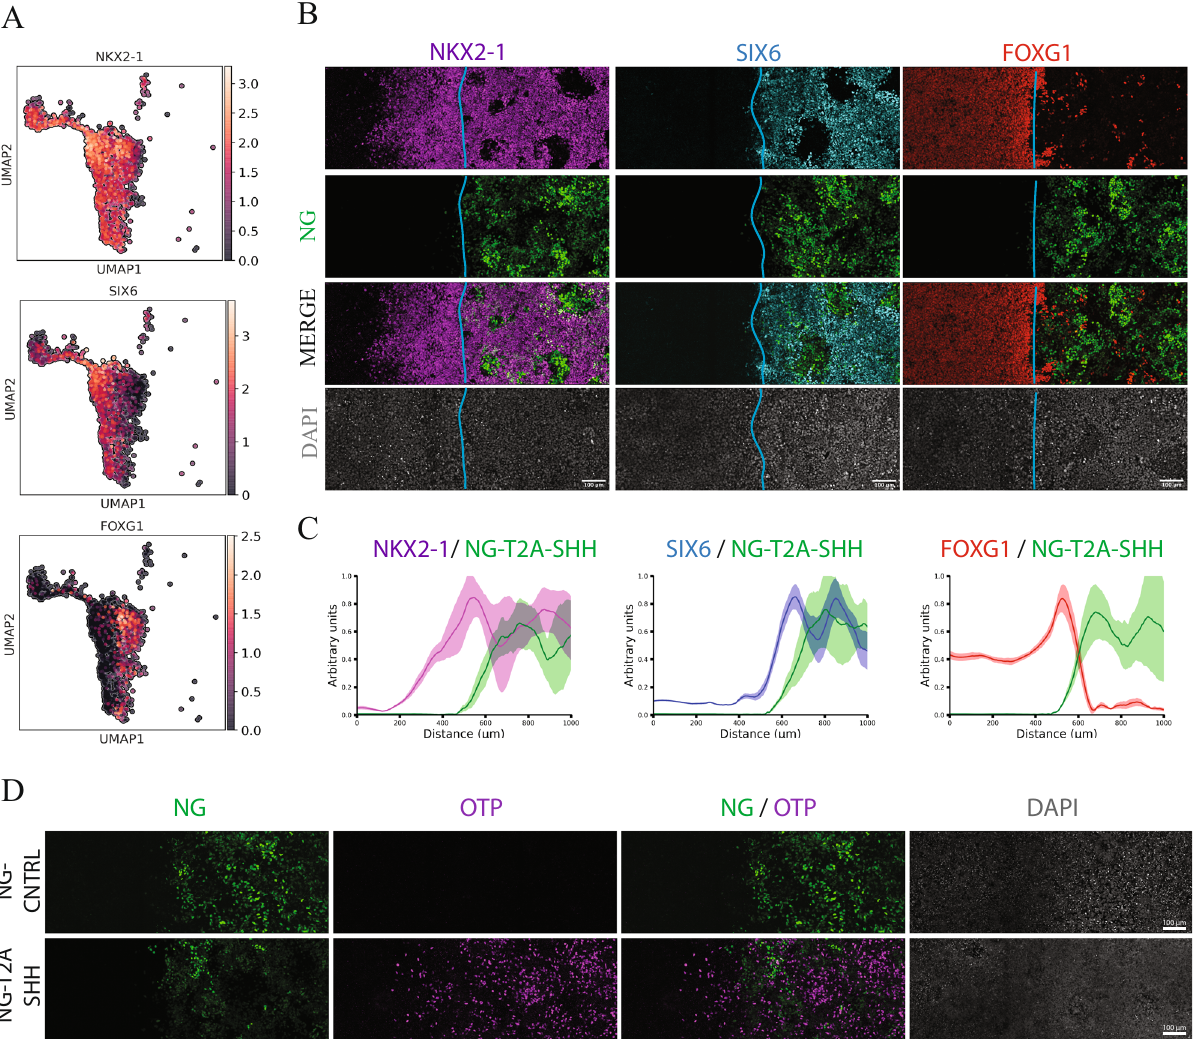
Fig. 4 Spatial self-organization of telencephalic and hypothalamic fates upon light-induced SHH. A UMAP plot showing a selected population of cell NKX2-1 + . Expression of markers that distinguish hypothalamic and telencephalic populations (NKX2-1, SIX6 and FOXG1). B Immunostaining shows the spatial segregation of ventral population arising from a light-induced SHH source at day 14. (Green NG, Magenta NKX2.1, Cyan SIX6, Red FOXG1, Gray DAPI), Scale bar = 100 μ m. C Cumulative fl uorescence intensity analysis (line pro fi le) over the x -axis. x -axis displays the linear distance in μ m. y -axis shows the cumulative fl uorescent intensity pro fi le in arbitrary units for each channel. Line pro fi le shows the average (line) and SD (area) for each channel. The line pro fi le is color-coded as the immuno fl uorescent channels, NG-Green, NKX2-1-Magenta, SIX6-Cyan, FOXG1-Red at day 14 quanti fi cation ( n = 3 biologically independent samples). D Immunostaining shows OTP positive cells induced in proximity of the NG-T2A-SHH organizer but not in the NG- CNTRL. Light induced SHH drive the self-organization of both neural progenitors and neurons (Green NG, Magenta OTP, Gray DAPI), Scale bar = 100 μ